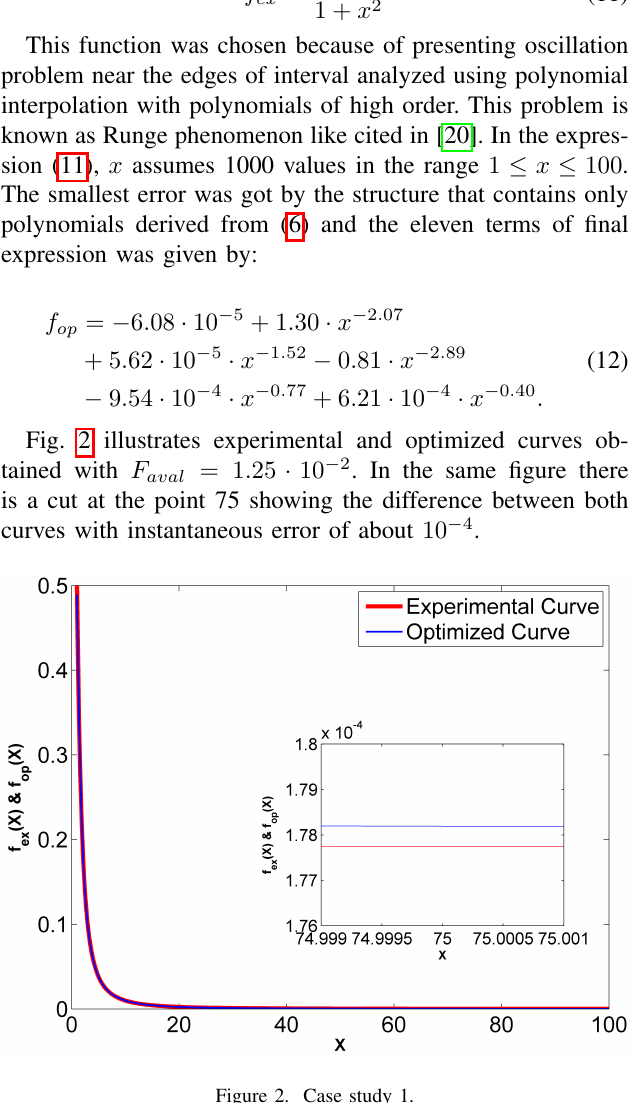
Figure 2. Case study